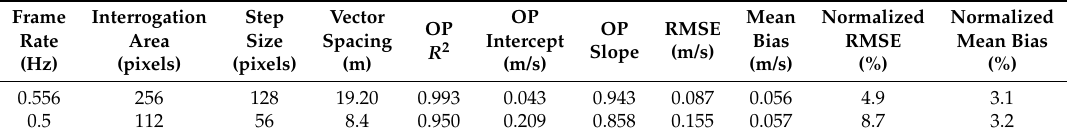
Figure 9. PIV-derived velocity vectors for the ( a ) optimal parameter combination and ( b ) an alternative parameter combination that was nearly as accurate but provided a higher density of output vectors. Corresponding observed vs. predicted regression accuracy assessments for the ( c ) optimal and ( d ) alternative parameter combinations. Note that the vector length in each panel is dictated by the spacing between vector origins and does not scale with the magnitude of the velocity vectors, which is similar for both panels. Table 4. Summary of PIV results from the Tanana River 2019 data set for the two parameter combinations illustrated in Figure 9. Pixel size is fixed at 0.15 m. OP = Observed versus Predicted; RMSE = root mean squared error; bias is calculated as ADCP–PIV; RMSE and bias are normalized by the mean velocity recorded by the ADCP (1.78